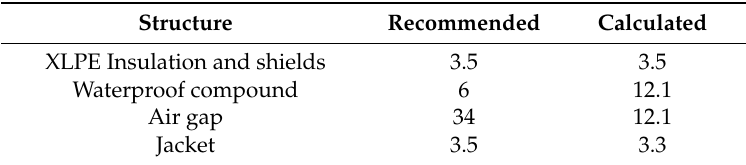
Table 6. Thermal resistivities of the tested 110 kV single-core XLPE cable [(K · m/W)].